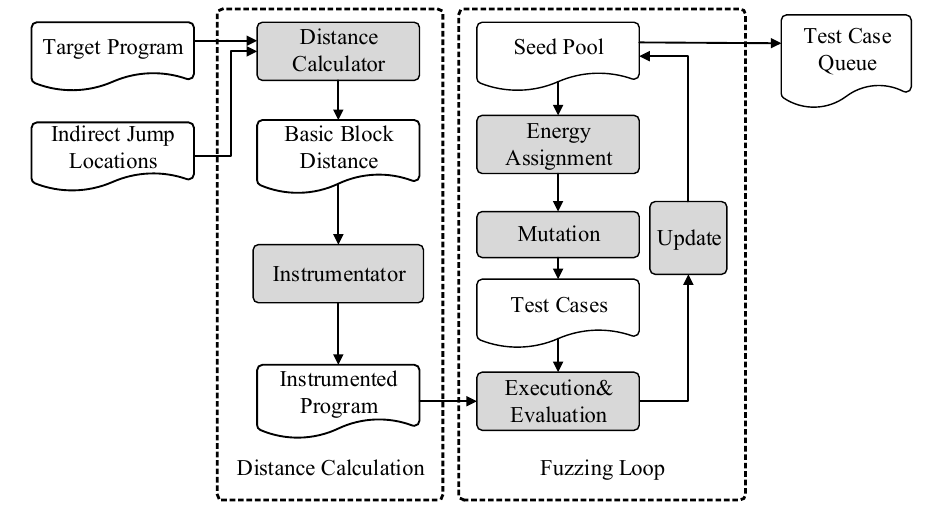
Figure 4. Input generation based on